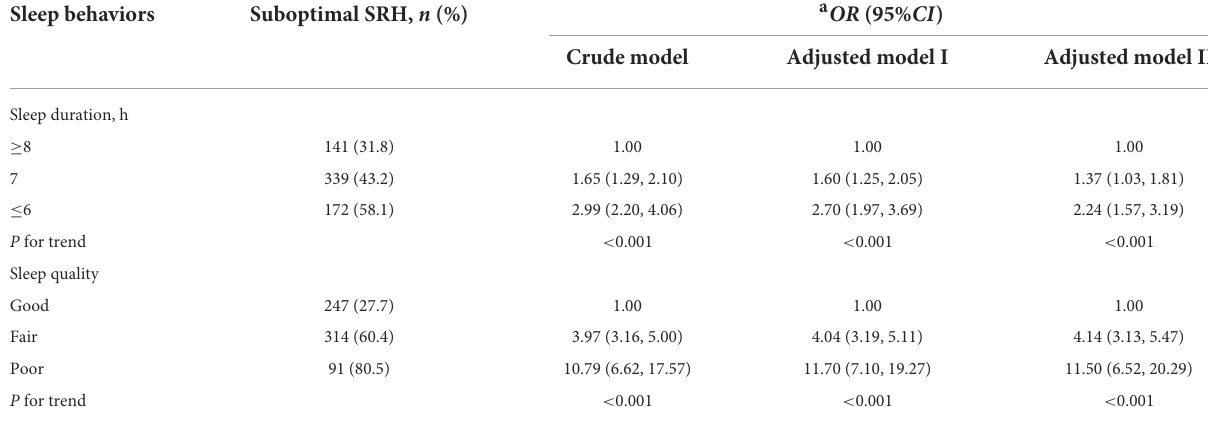
TABLE 2 Association of sleep duration and sleep quality with suboptimal SRH among medical students. Sleep behaviors